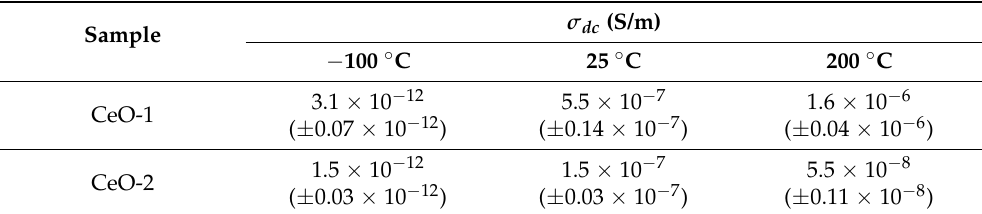
Table 2. Numerical values of σ dc retrieved from the Cole-Cole fittings at low ( − 100 ◦ C), room (25 ◦ C) and high (200 ◦ C) temperatures for cerium oxide nanoparticles.